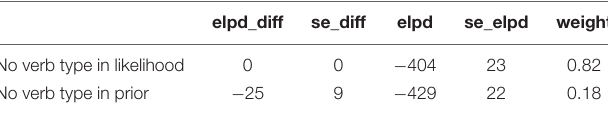
TABLE 21 | Model with no verb type in the likelihood compared to a model with no verb type on the prior, Experiment